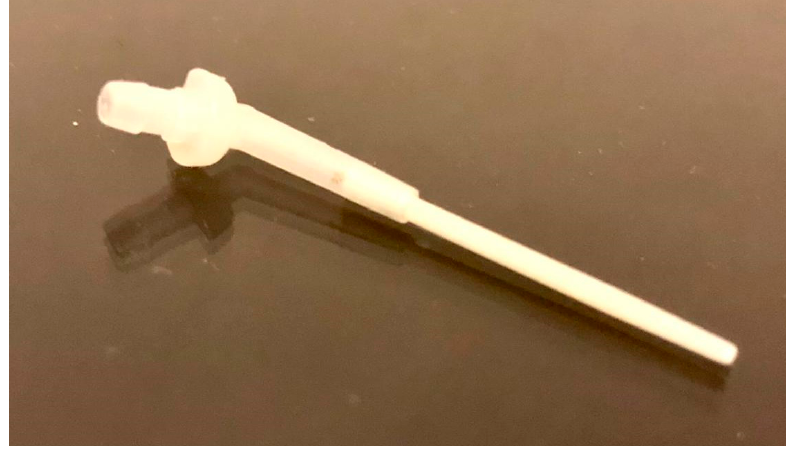
Figure 1. The tested hollow post.